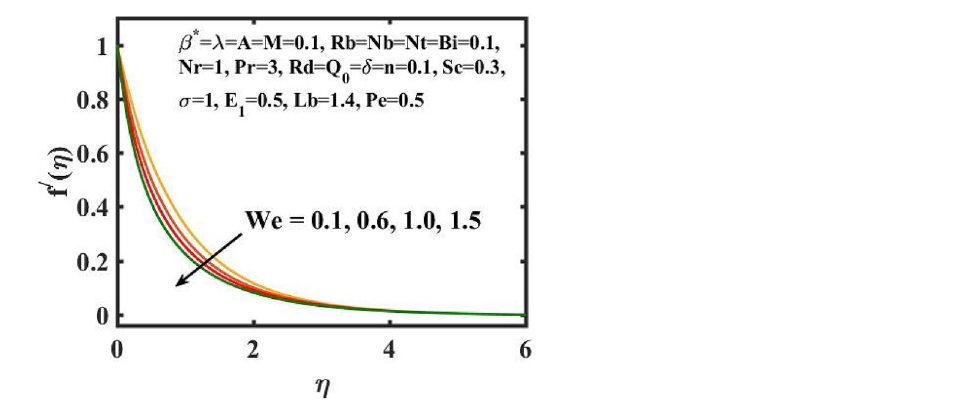
Figure 3. Encouragement of We on f ′ (η) .